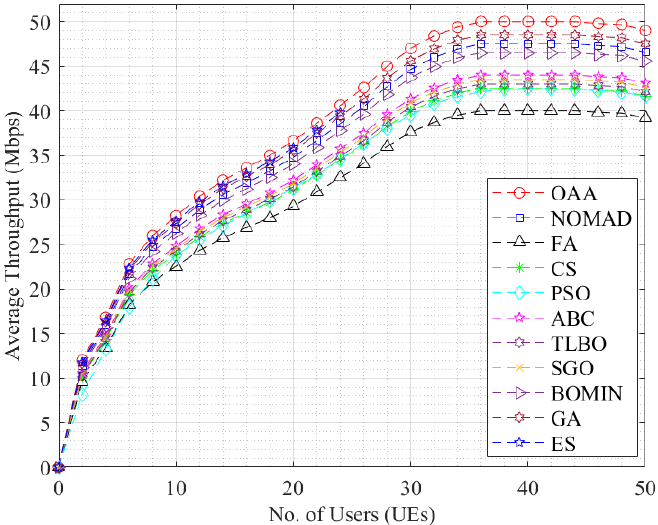
Figure 13. Average throughput of the network with OAA and other algorithms.